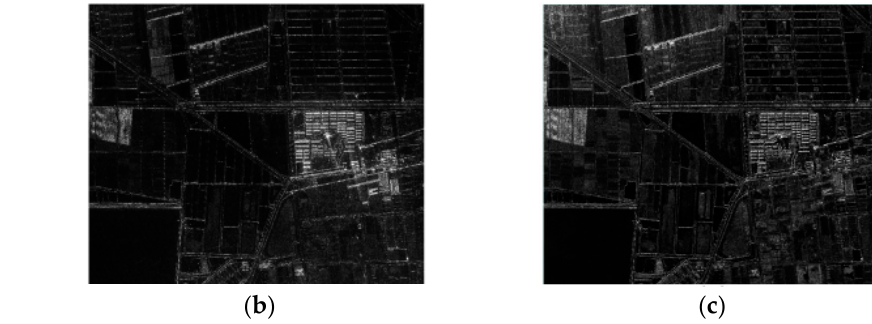
Figure 7. Image registration and cropping. ( a ) L-band SAR images. ( b ) P-band SAR images. ( c ) C-band SAR images.